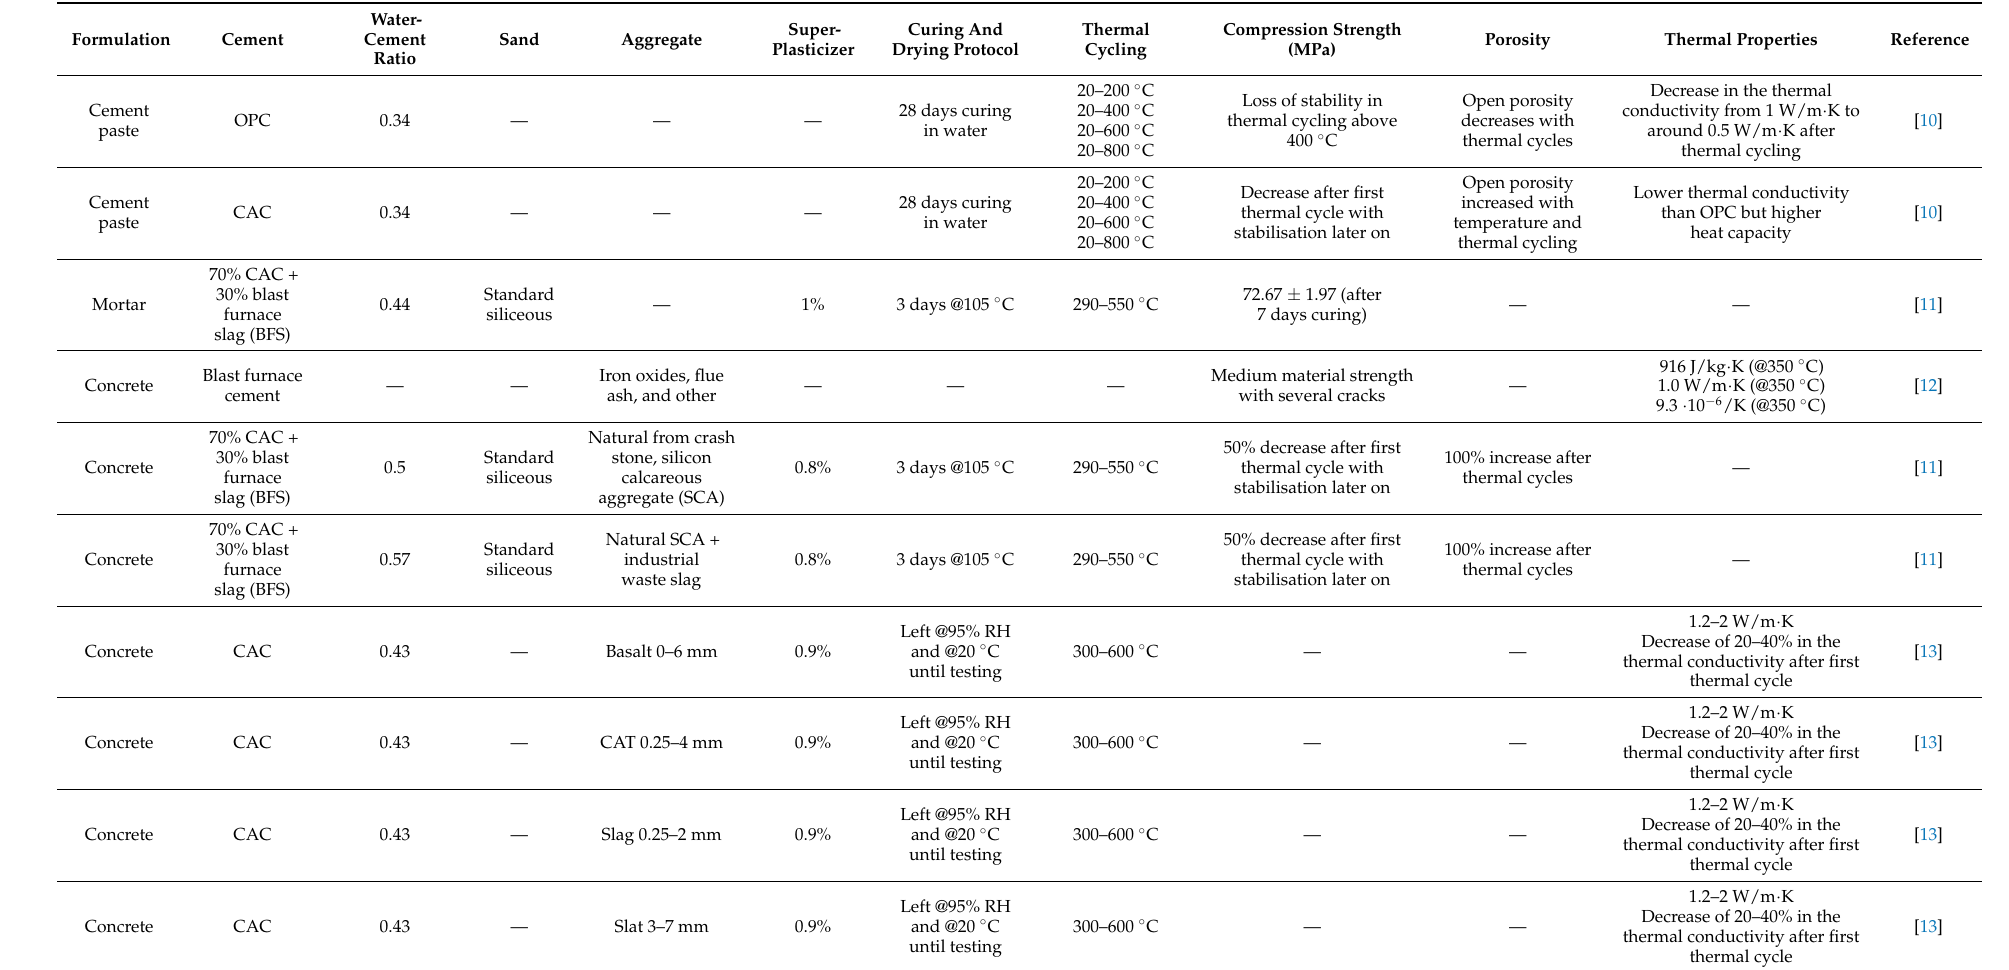
Table 1. Summary of innovative concrete formulations for high temperature